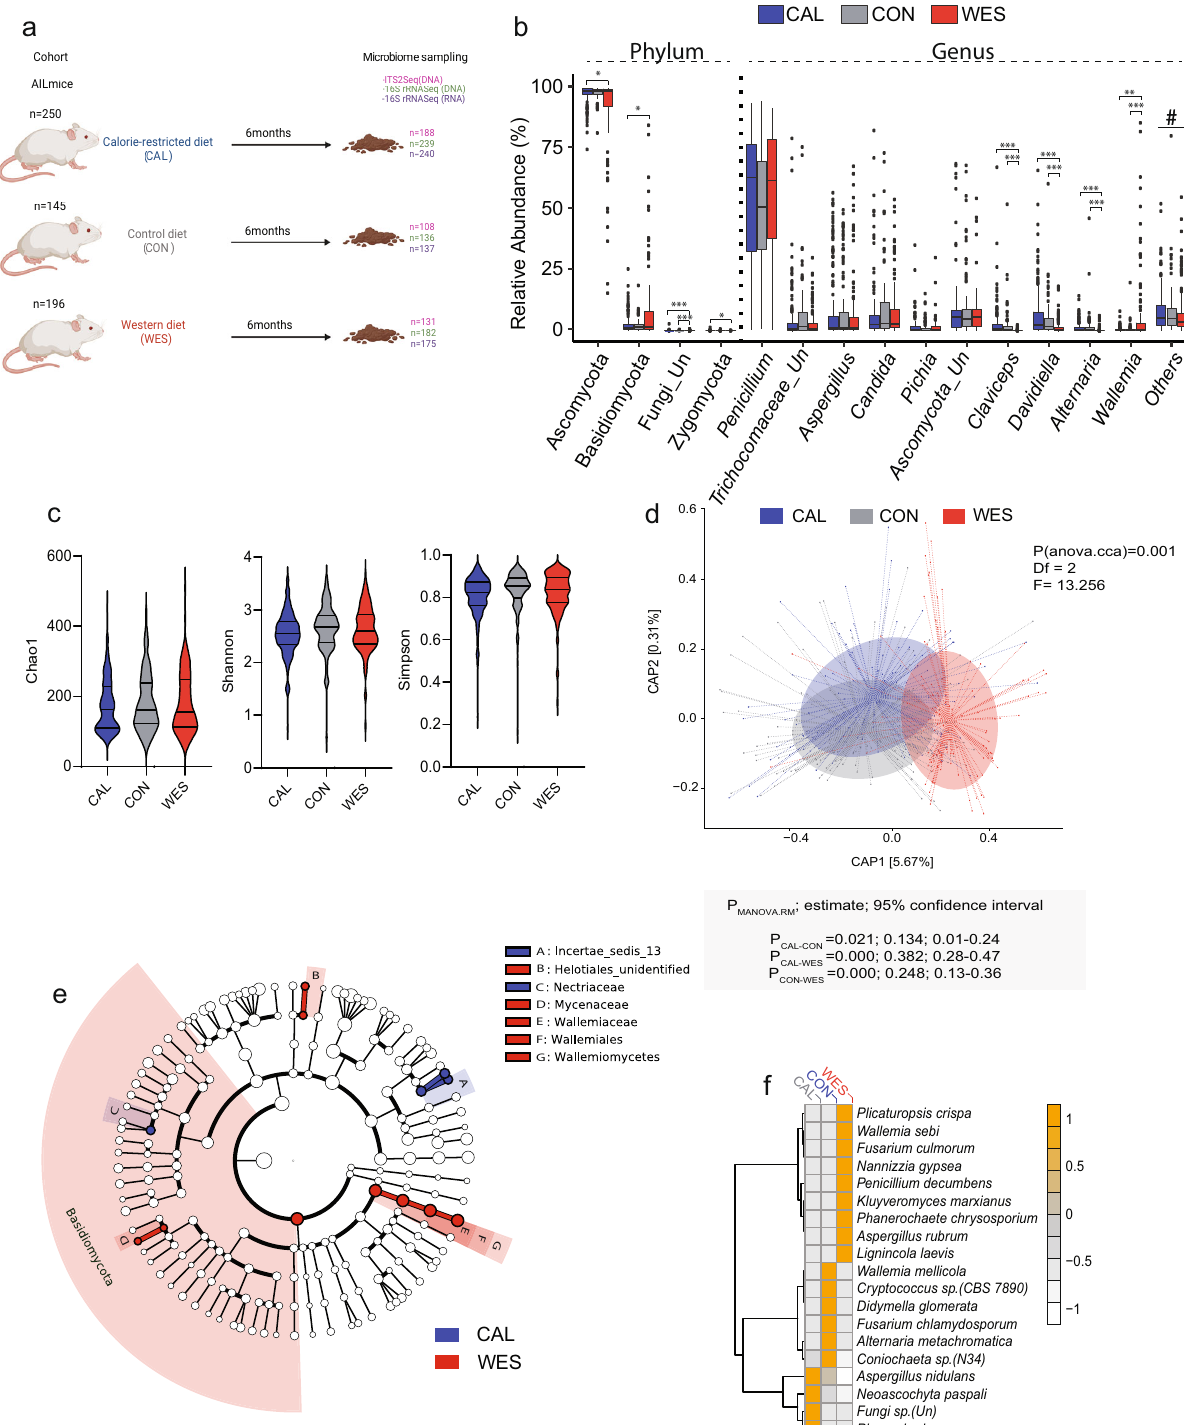
P MANOVA.RM ; estimate; 95% confidence interval P CAL-CON =0.021; 0.134; 0.01-0.24 P CAL-WES =0.000; 0.382; 0.28-0.47 P CON-WES =0.000; 0.248;